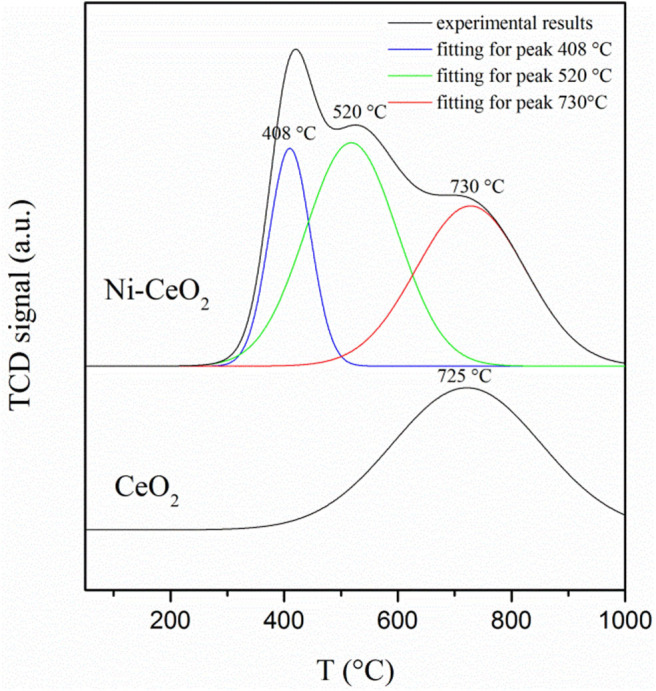
Hydrogen temperature programmed desorption profiles for CeO2 and Ni–CeO2 powders.